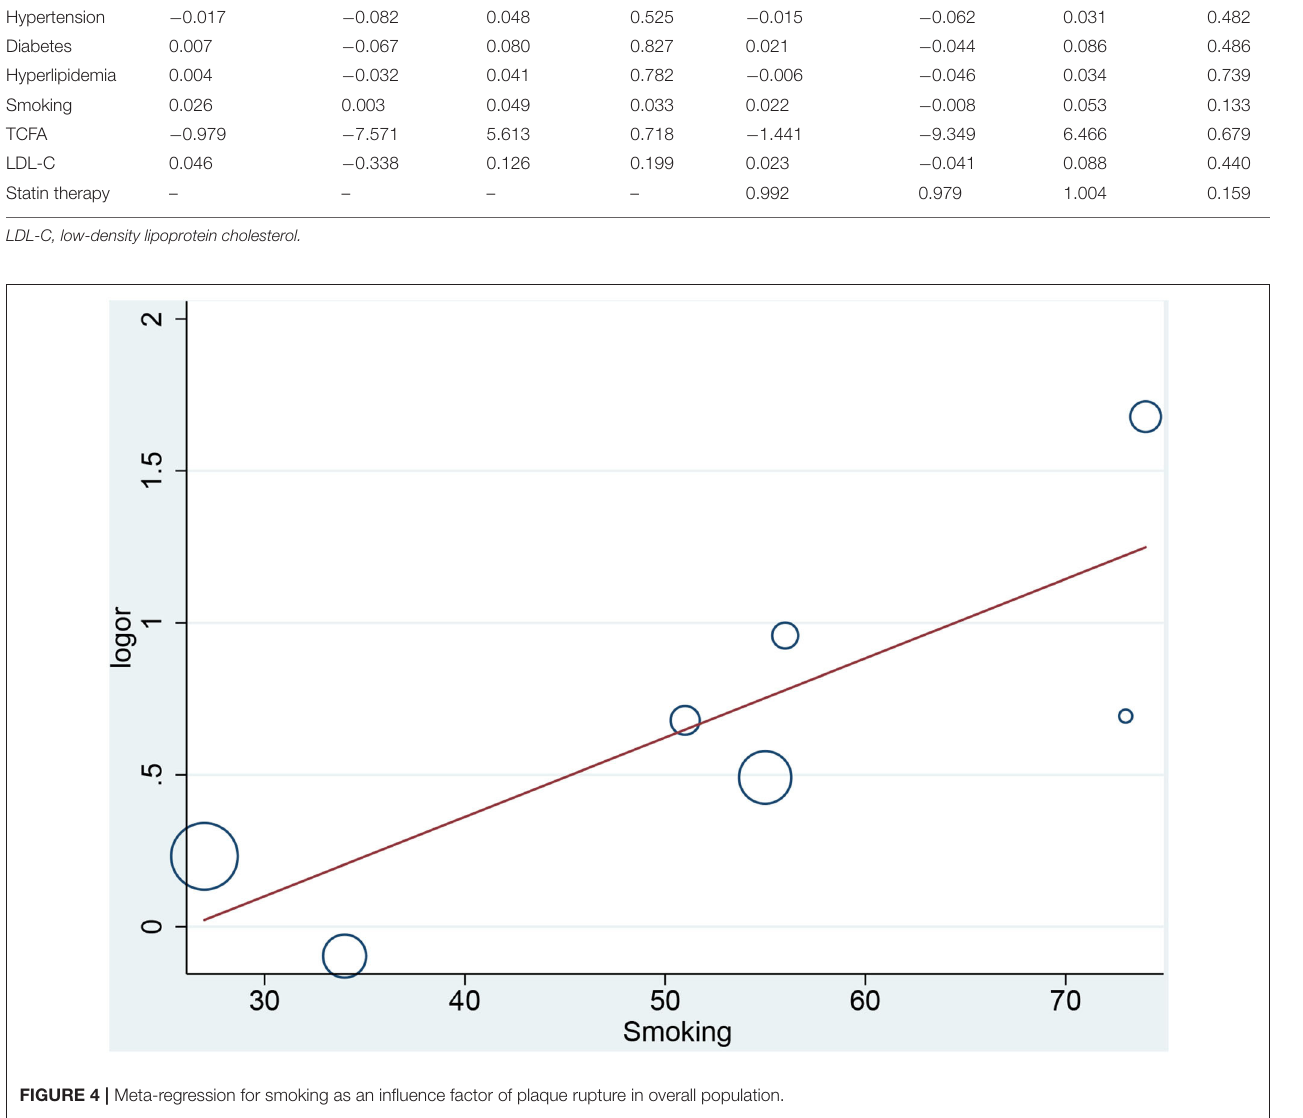
FIGURE 4 | Meta-regression for smoking as an influence factor of plaque rupture in overall